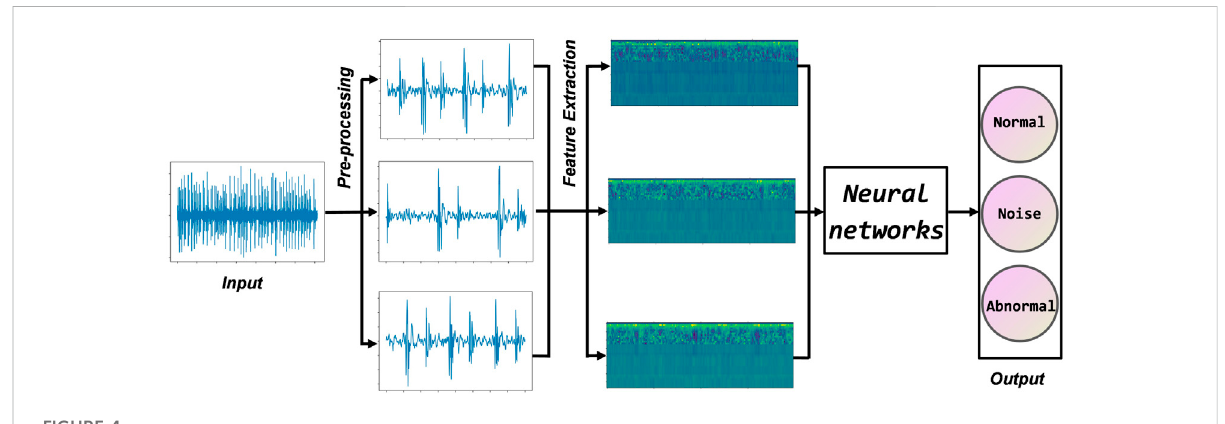
FIGURE 4 Flow chart of the proposed